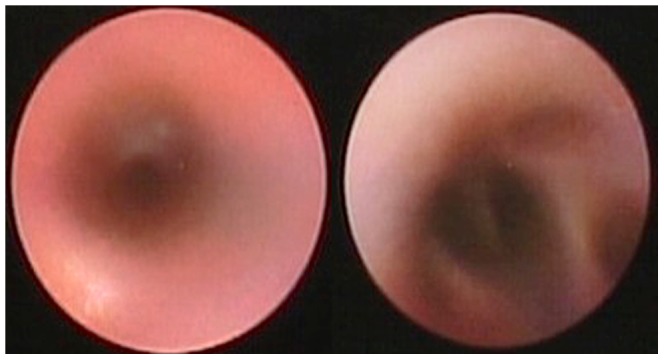
Real-time imaging provides peripheral bronchial intraluminal information and peripheral bronchial branches in a healthy canine.